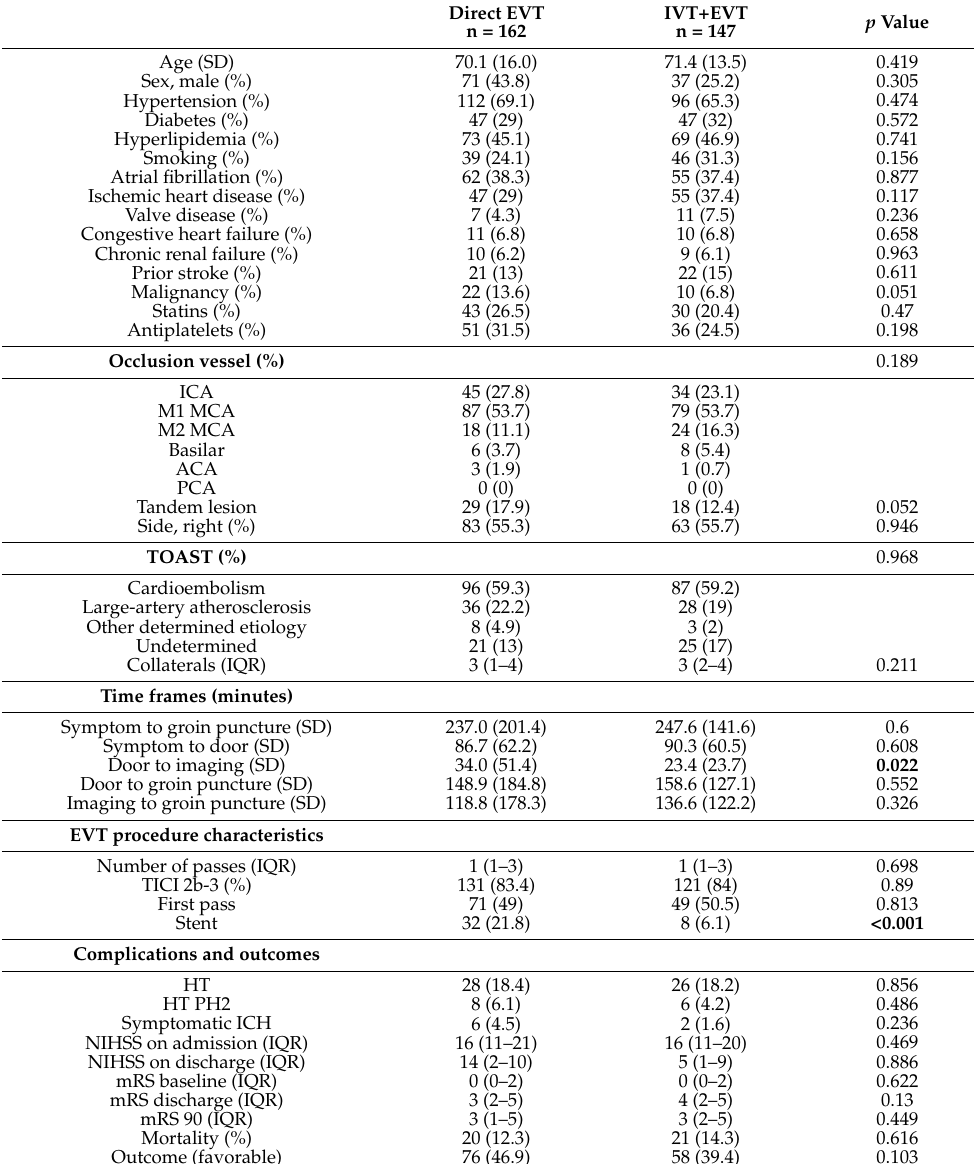
Table 1. Characteristics of patients in the direct EVT and IVT+EVT